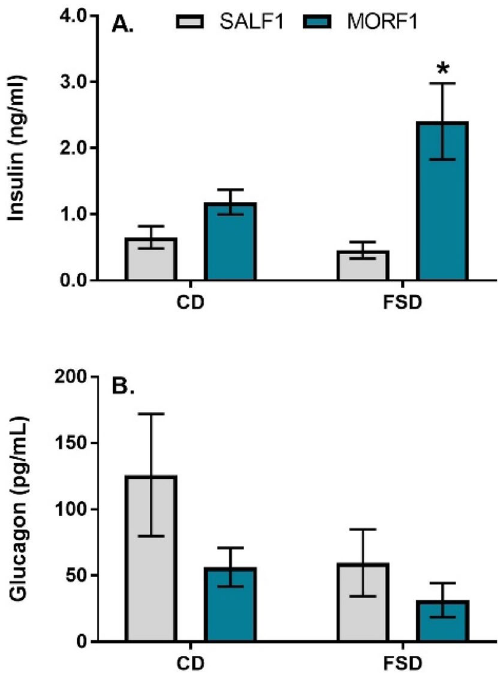
Figure 3. Panel ( A ): Mean (± SEM) plasma insulin levels (ng/ml) following a 24 h fast; SALF1 CD N = 6; SALF1 FSD N = 5; MORF1 CD N = 5; MORF1 FSD N = 6; * p < 0.05 as compared to SALF1 FSD. Panel ( B ): Mean (± SEM) plasma glucagon levels (pg/ml) following a 24 h fast; SALF1 CD N = 8; SALF1 FSD N = 9; MORF1 CD N = 6; MORF1 FSD N =